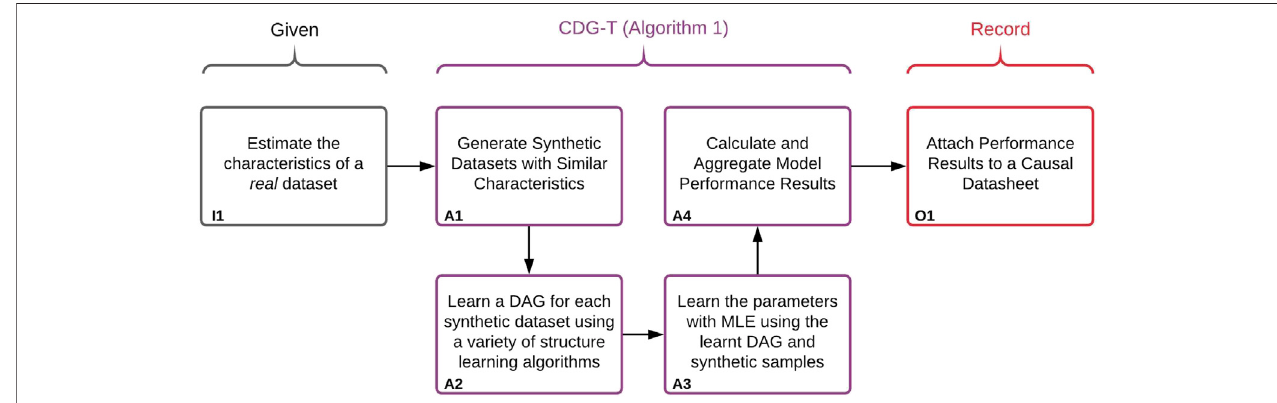
FIGURE 3 | Illustration of the approach used to create the Causal Datasheets presented in Section 3 . Algorithm 1 refers to the algorithm labelled Algorithm 1 : CDG-T Overview